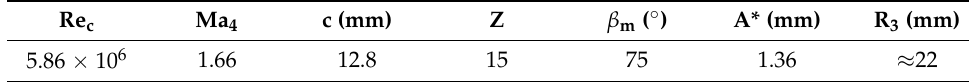
Table 1. Mesh sensitivity analysis vane features.